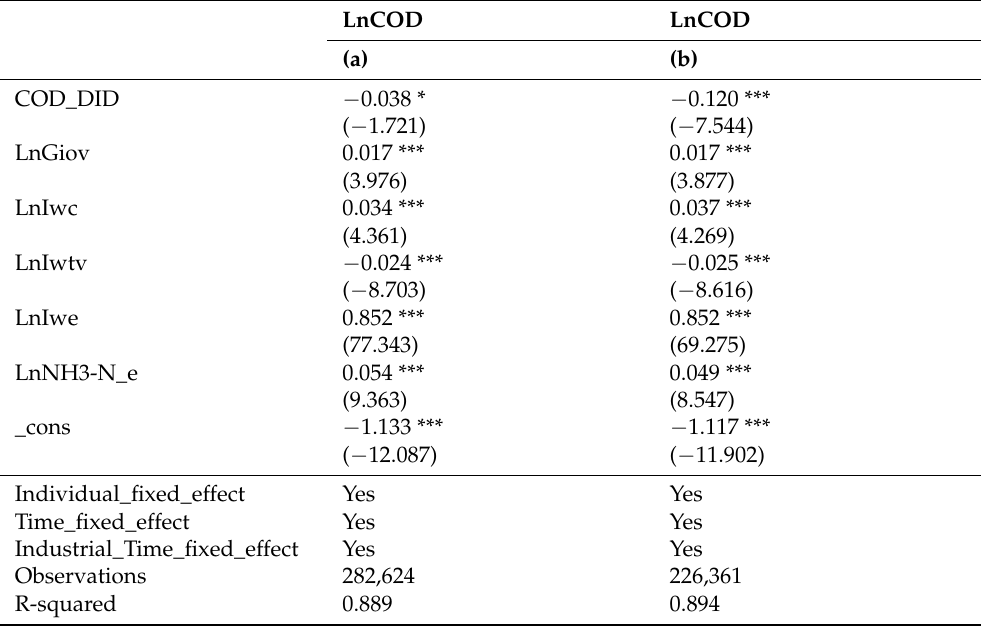
Table 5. Excluding four municipalities and excluding the impact of low-carbon